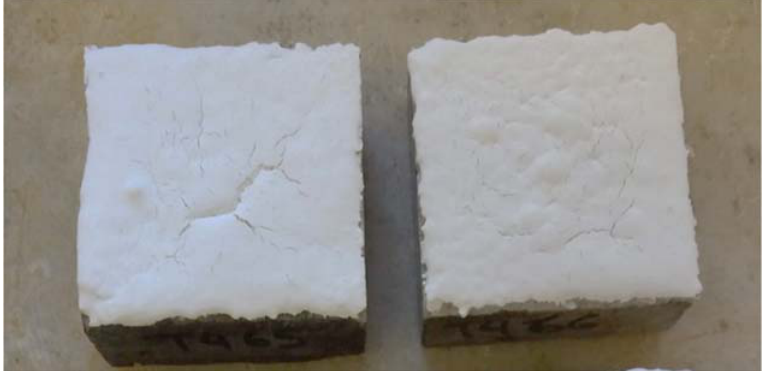
Figure 4. Concrete blocks (specimens) coated on one side (50 × 50 mm) by the M1cm